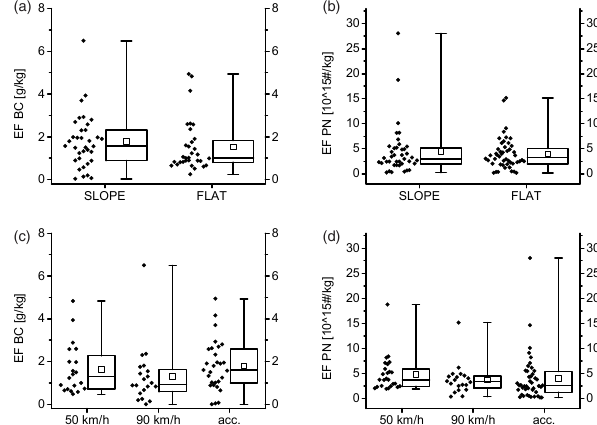
Figure 3. Stationary measurements of BC and PN emission factors for measurements performed on a slope and flat road (a and b) ; and at different speeds of passing cars (c and d) . Values marked are the minimum and maximum ( − ), 25th and 75th percentile (lower and upper box lines), median (middle box line), and mean ( (cid:3) ). Black dots represent the actual data points.